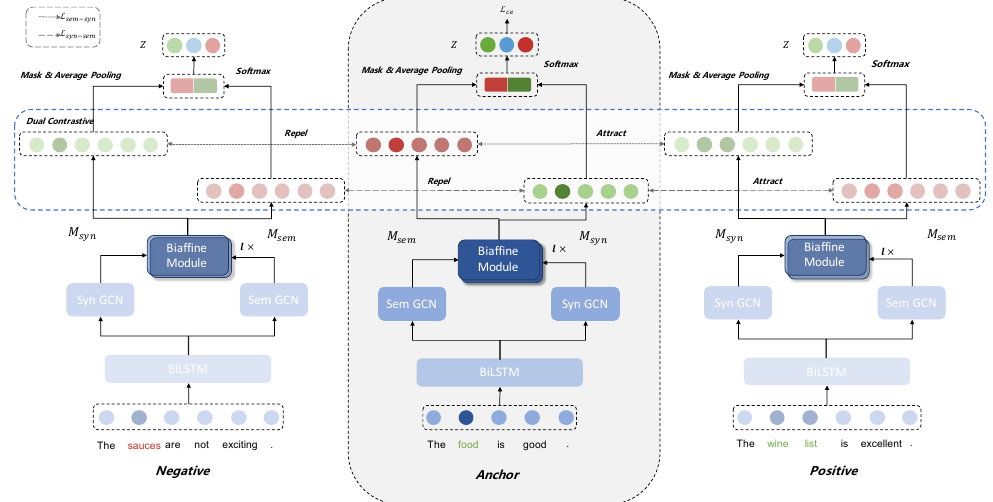
Figure 3. The overall architecture of our Triplet Contrastive Learning